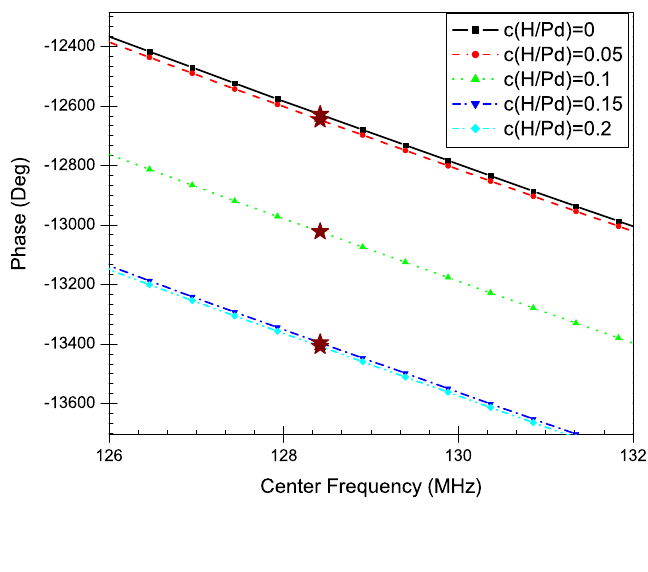
Figure 7. Phase profiles up to a concentration level of 0.2 a.f. The ( (cid:144) ) sign illustrates the phase value at the center